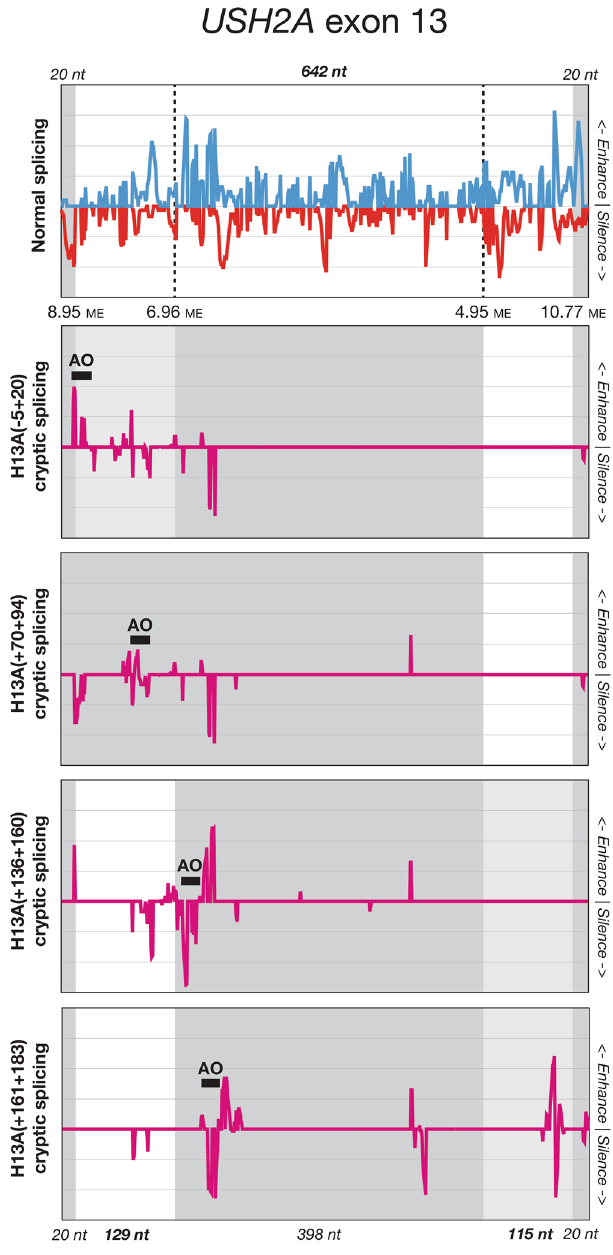
Figure 3. Net changes to predicted exon splicing enhancer/silencer (ESE/ESS) access in four examples of antisense oligonucleotide (AO)-induced cryptic splicing of USH2A exon 13. Blue lines indicate ESE access and red lines indicate ESS access, purple indicates the net change in ESE and ESS access as a result of AO binding. Grey shading indicates pre-mRNA sequence excluded from the mature transcript, and pale grey indicates regions with intermediate inclusion. Region sizes and Maximum Entropy scores for cryptic and canonical splice sites are also